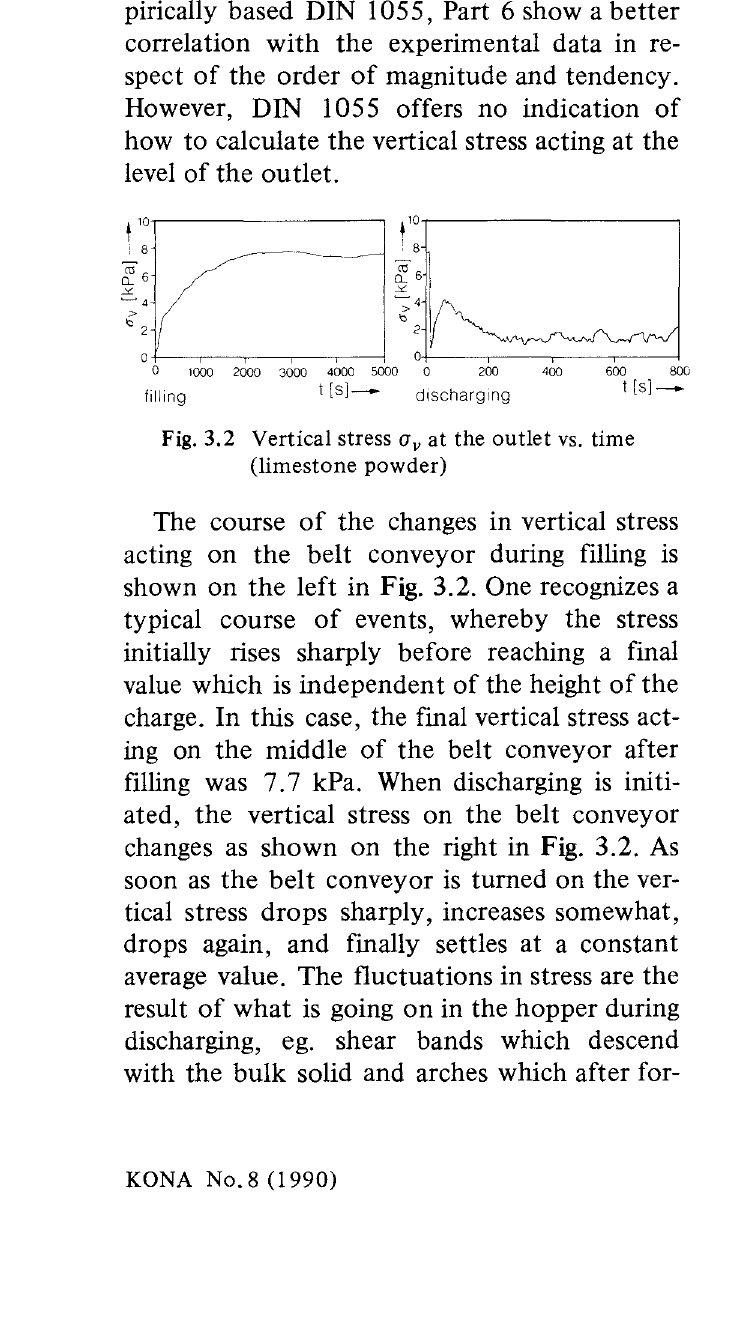
Fig. 3.2 Vertical stress Ov at the outlet vs. time (limestone powder) Fig. 3.3 Vertical stress at the level of the outlet